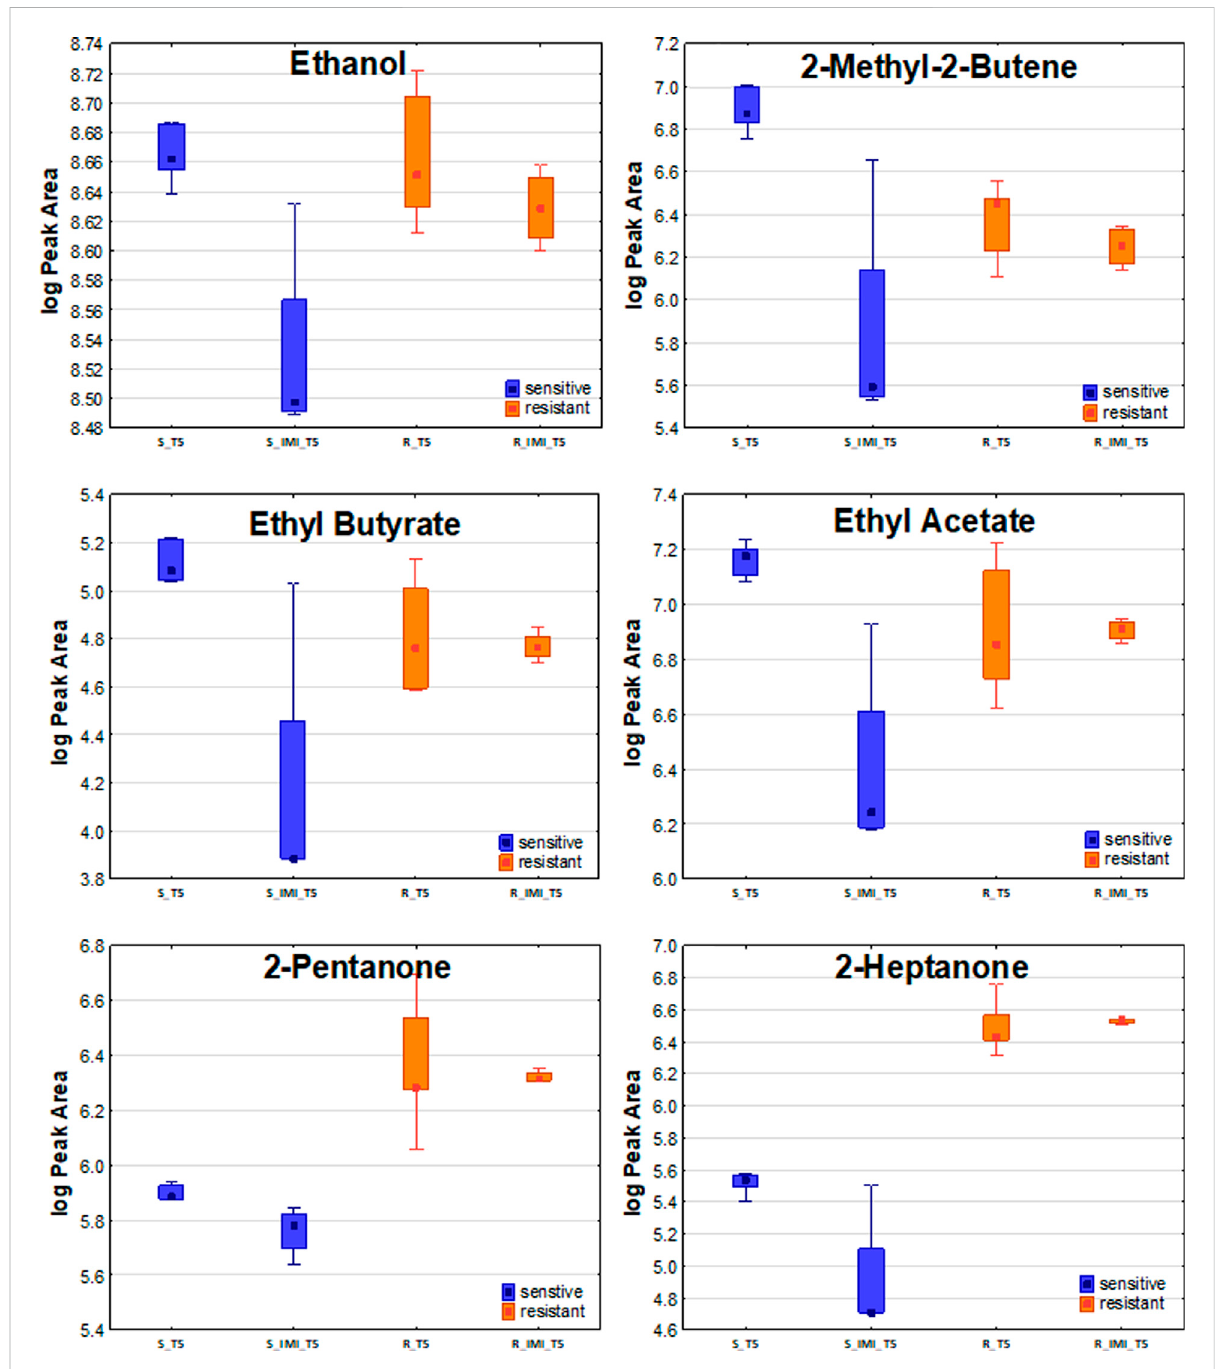
FIGURE 5 Theeffect ofimipenem onmetabolitessecretion fromKlebsiellapneumonia.Asigni fi cantdecline inVOCsamounts inbacterialheadspace was found for sensitive strains (blue boxes on the left) but not for resistant ones (orange boxes on the